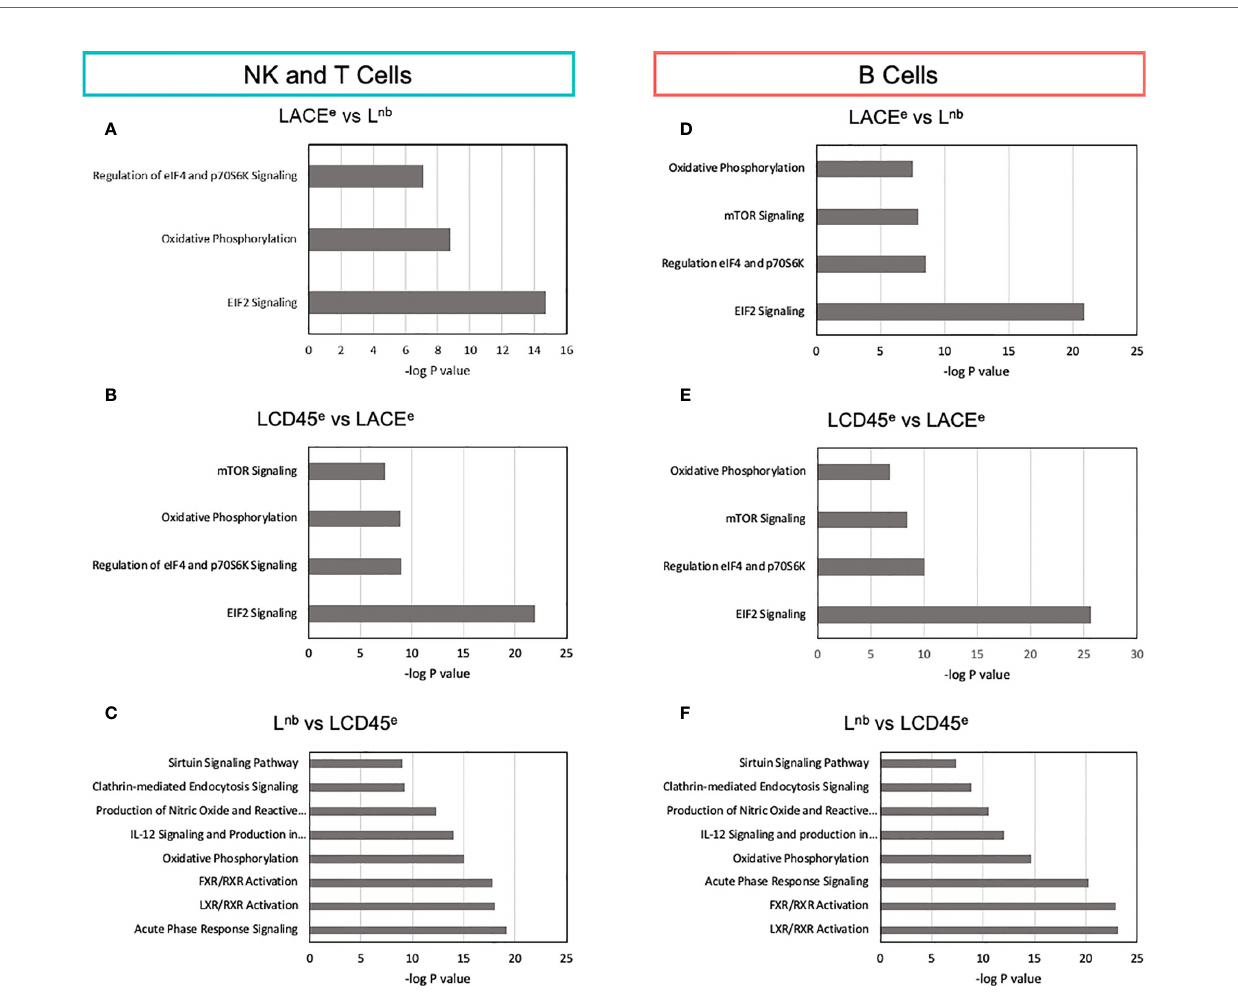
FIGURE 5 | Characterization of differentially expressed genes points to signaling pathways that differ between datasets. (A) Pathway analysis of NK and T cells based on differential expression between the LACE e and L nb datasets. (B) Identi fi cation of canonical pathways altered between LCD45 e and LACE e . (C) Pathway analysis of NK and T cells based on differential expression between L nb and LCD45 e in NK and T cells. (D – F) B cell pathway analysis as in A-C. The same comparisons were made for myeloid cells and plasma cells and were largely similar to what is shown for the immune subpopulations represented in this fi gure. Bars represent -log(P values) of each canonical pathway ’ s likelihood of being altered between comparisons and was obtained with Ingenuity Pathway Analysis Software